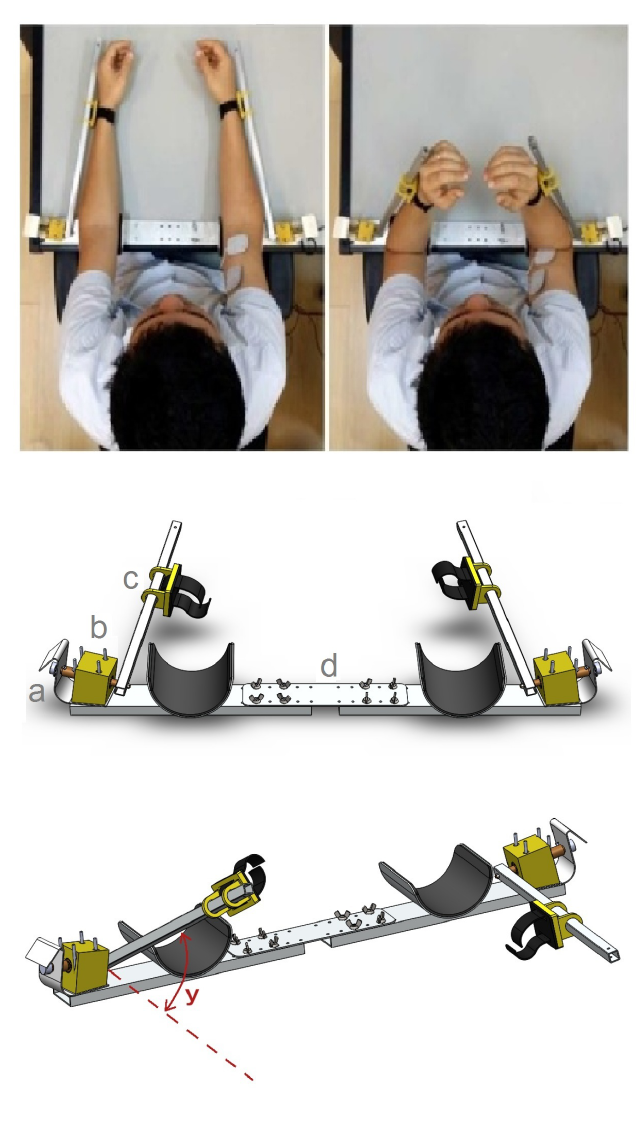
Figure 1 - Mechanical apparatus for NMES experimental tests. The point a in the image indicates a goniometer (simple potentiometer) linked to a steel axis b allowing angular displacement readings. Letter c shows that the wrist has an attachment with linear freedom of movement along the aluminium square rod, while d points out that there is an ad- justment for the lateral distance of the elbows. In picture on the bottom, the controlled joint angle, denoted by y , and the equipment are shown in a different view. A pair of electrodes per muscle are been used for the electrical stimulation. For instance, the pair of electrodes on the biceps muscle of the volunteer can be seen in picture on the